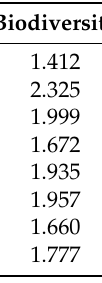
Figure 7. Map clustering tree based on DGGE. Table 2. Biodiversity change during the